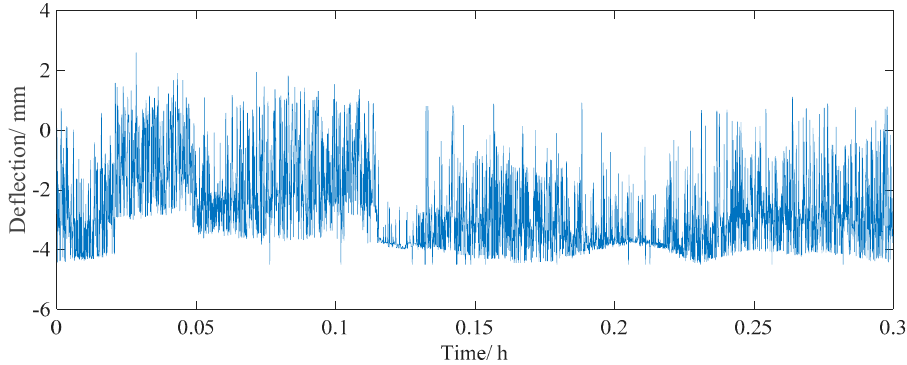
Figure 15. Raw real-time monitored deflection data for half an hour.